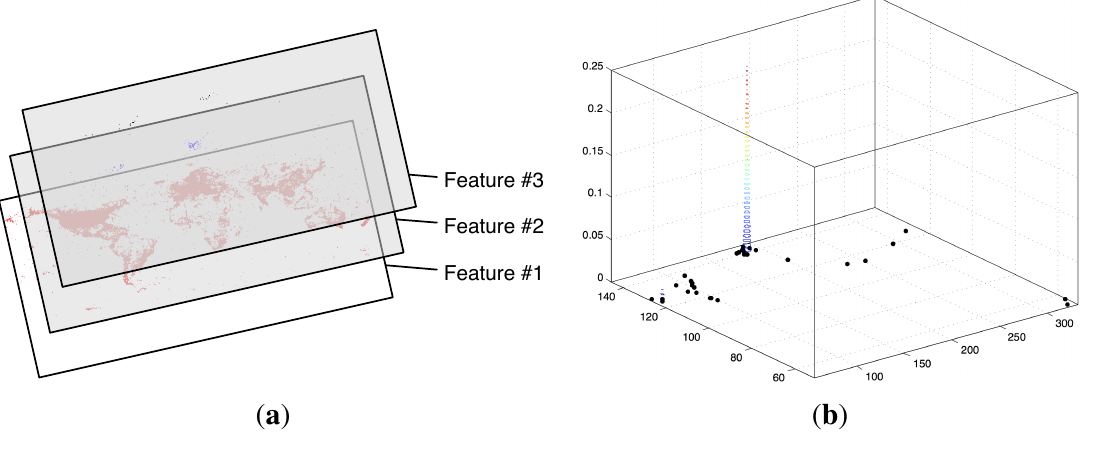
Figure 6. Our approach to the geographical location of images. ( a ) A number of features are extracted from the content and metadata of a query image; each feature provides a set of latitude-longitude points associated with that feature (learned from the geotagged training images); ( b ) the location of predominant mode of the density distribution of all the features is determined using the standard mean-shift algorithm; this gives an estimate of the location, as well as the probability of it being correct (based on the likelihood of the